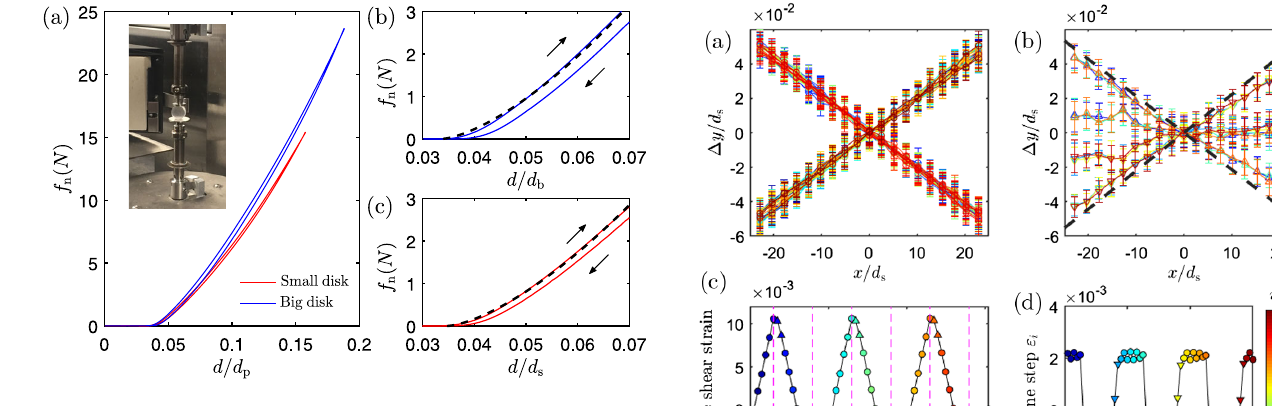
FIG. 7. (a) Main: the normal contact force f experienced by a n small disk (red) and a big disk (blue) measured by the Micro- Strain Analyzer as functions of distance d moved by its upper arm ¼ d scaled by the diameter of the disk. Note that d for the small p s ¼ d for the big disk. The disks experience a disk and d p b compression-decompression load cycle, which leads to weak but noticeable hysteresis. The inset shows a picture of the loading FIG. 8. (a) Particle center displacements along the y direction as part of the TA Instruments RSA III Micro-Strain Analyzer, taken functions of their x positions between consecutive quasistatic shear from Ref. [74] with permission. (b) and (c) show enlarged steps that show nice linear relation as expected for a uniform shear. versions of the same data as in (a), where the evolution direction The coordinate system is plotted in Fig. 1(a). Each curve of the system is indicated by the arrows. The black dashed curves corresponds to averaged data for one shear step [from i th to in (b) and (c) are fit results using Eq. (A1) for the big and small i þ 1 th step, with i labeled based on color bar to the right in (d)] disk, respectively. with a bin width 2 . 5 d , the diameter of a small disk. (b) Particle s displacements from the abnormal steps following the change of driving directions. The curves are measured from shear steps with the same type of marker shape and color shown in (c) and (d). In (a) and (b), error bars show the standard deviation obtained from the averaging process, which is about 0 . 01 d , near the limit of our s center detection precision. In (b), the two dashed black lines show linear fit results from data in (a) that are under forward and reverse shear. (c) The accumulative shear strain starting from a state right before one complete shear cycle. In both (c) and (d), the triangles show abnormal steps, and the circles show normal steps. (d) The strain caused by one shear step as defined in Eq.